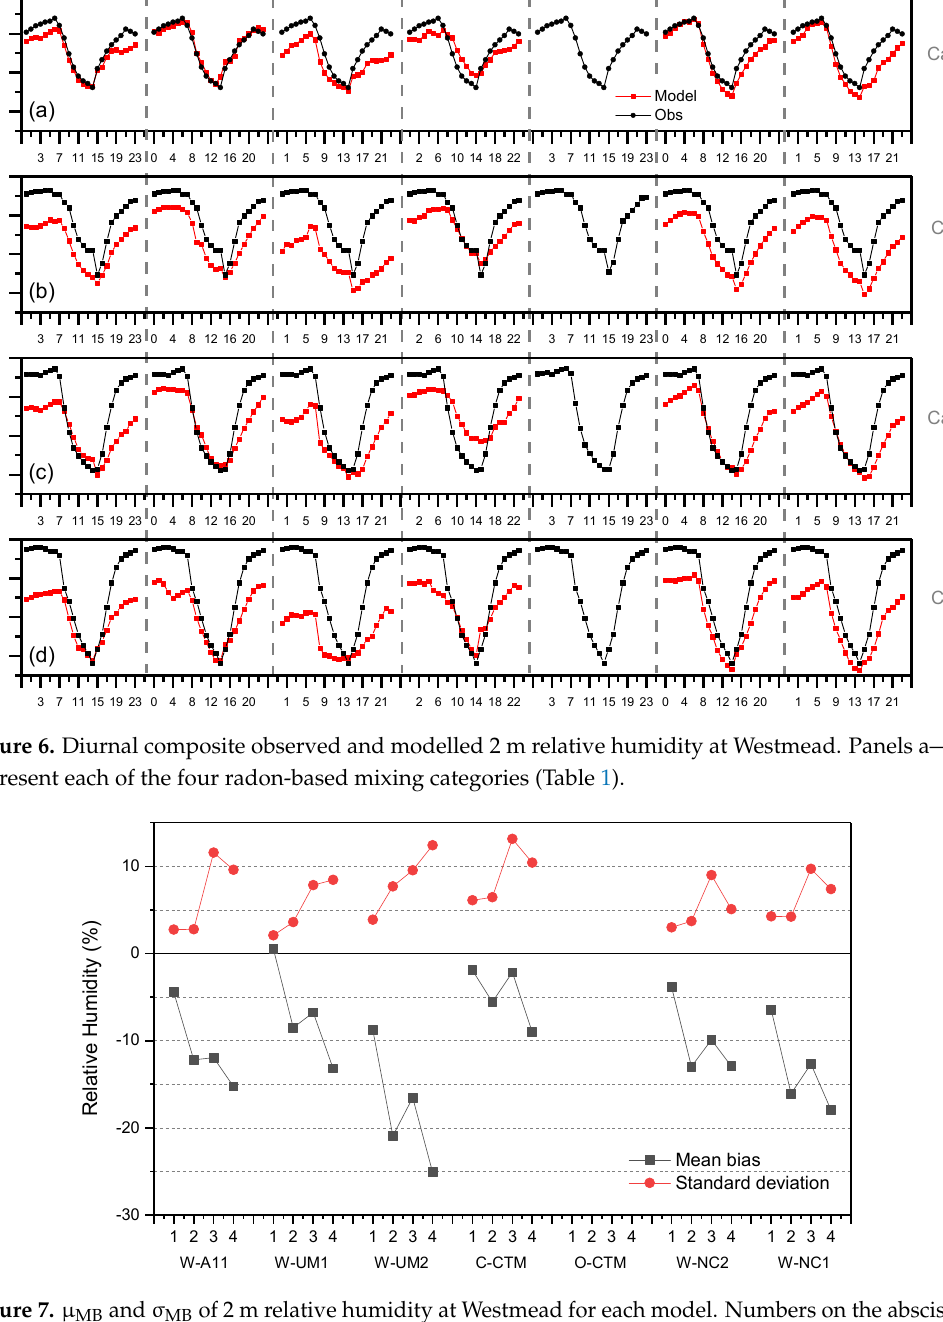
Figure 7. µ MB and σ MB of 2 m relative humidity at Westmead for each model. Numbers on the abscissa for each model represent the radon-based mixing states (categories #1 to #4) in Table 1. Although W-A11, W-UM1, W-UM2, O-CTM and C-CTM all over-predict pre-dawn